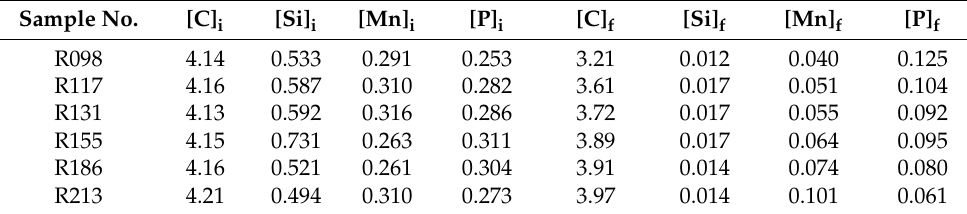
Table 2. Compositions of the initial hot metal and hot metal after dephosphorization (mass%). Sample No.